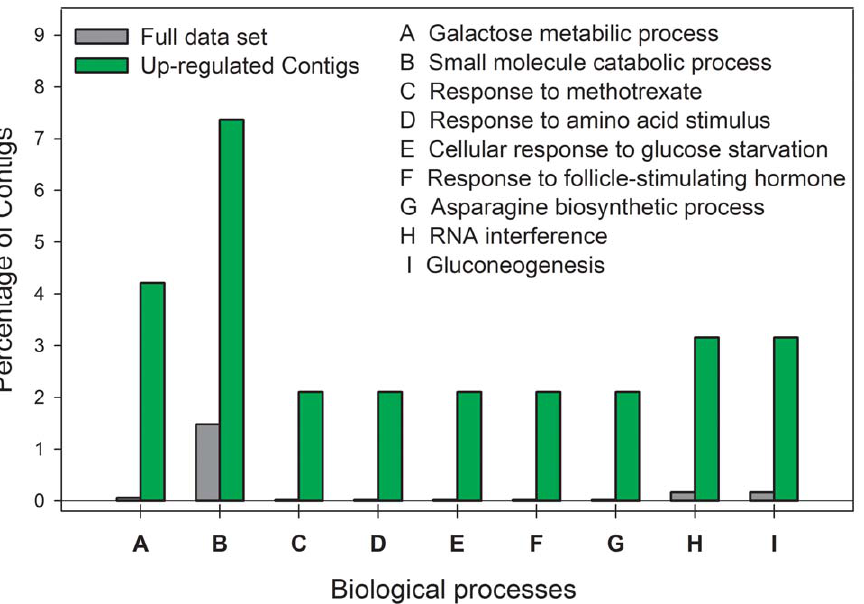
Figure 4. Biological processes over-represented in the sensitive genotype (S) after an Enrichment Analysis. The bars show the percentage of contigs associated with each GO term. The dark gray bars show the percentage of contigs associated with each GO term considering the full microarray data set. Green bars show the percentage of contigs associated with each GO terms, but only in the up-regulated date set